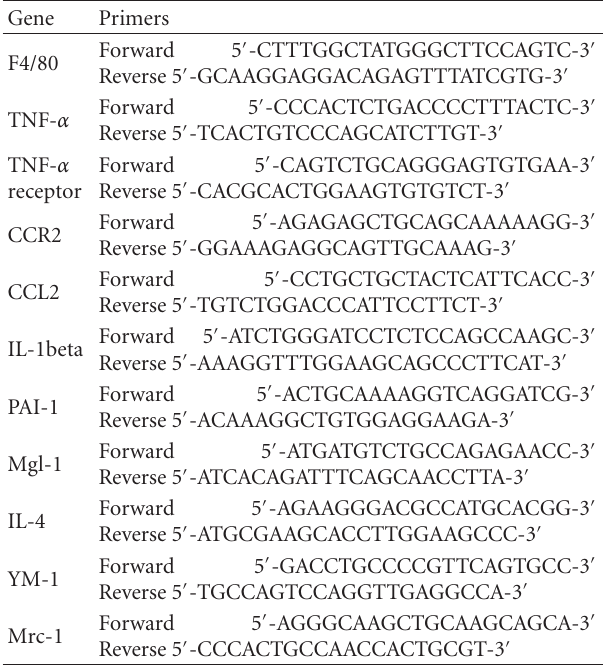
Table 2: Primers used in this